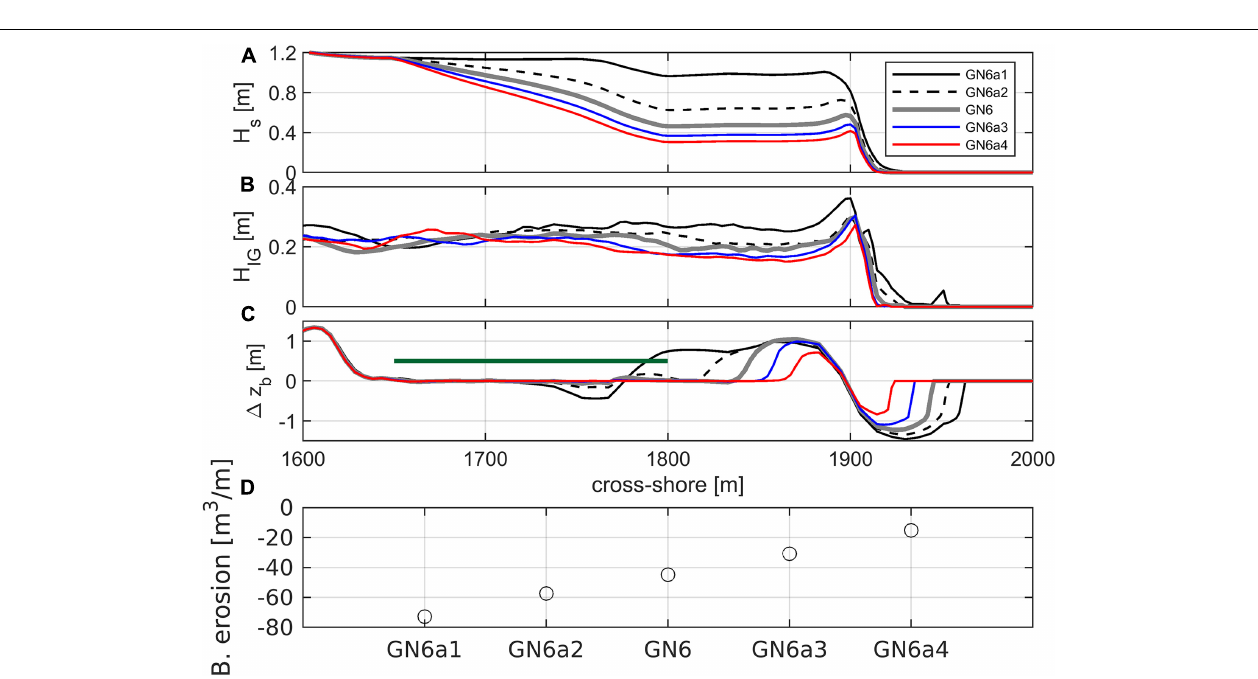
FIGURE 11 | Sensitivity to seagrass height ah, showing: (A) wave height distribution; (B) infragravity wave distribution; (C) seabed change after 100 days simulation; and (D) beach erosion.